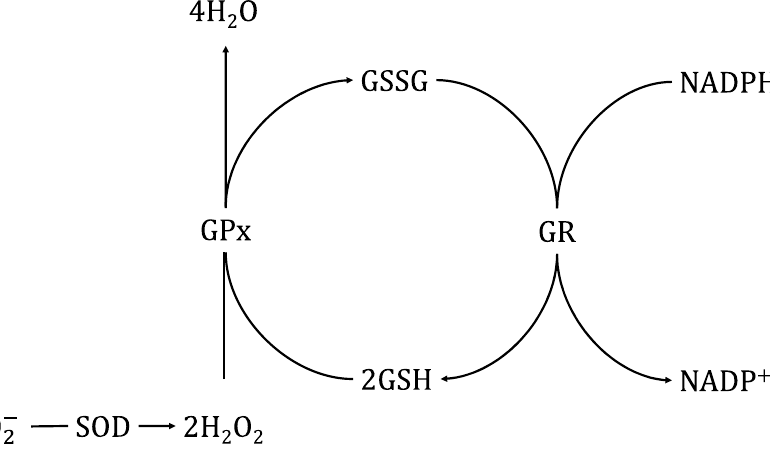
Figure 1. The roles of SOD, GPX and GR in the antioxidant defense enzyme system. Endogenous antioxidant enzymes, e.g., superoxide dismutase (SOD) or glutathione